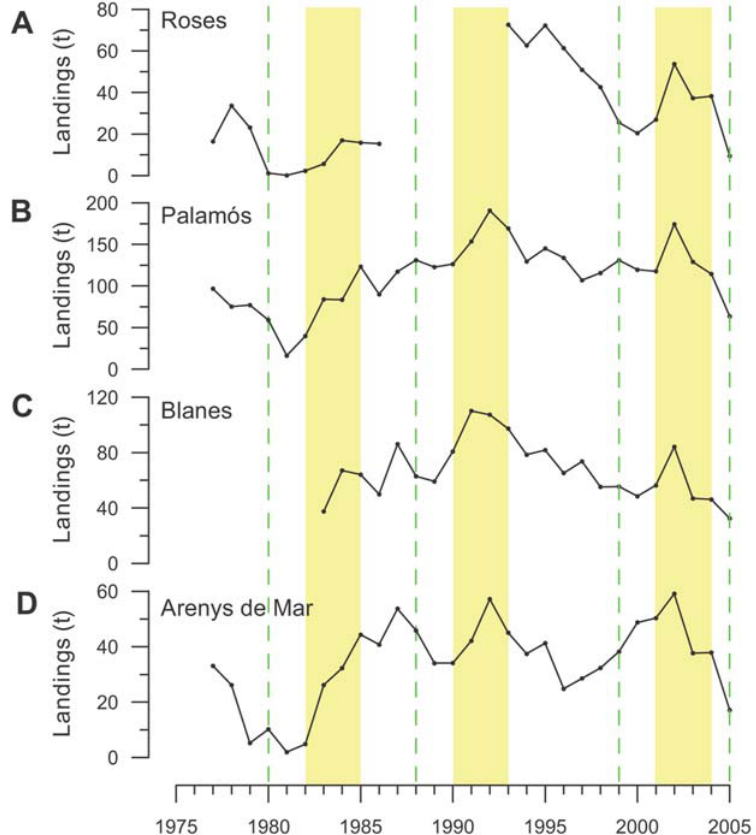
Figure 4. Temporal evolution of annual landings. (A–D) Available annual landings of Aristeus antennatus at the studied harbors since 1977. Green dashed lines indicate years when strong cascading events occurred. A similar temporal evolution of landings can be observed in all harbors, with an increasing trend and a peak of captures between 3 and 5 years after the cascading events (pale yellow bands).